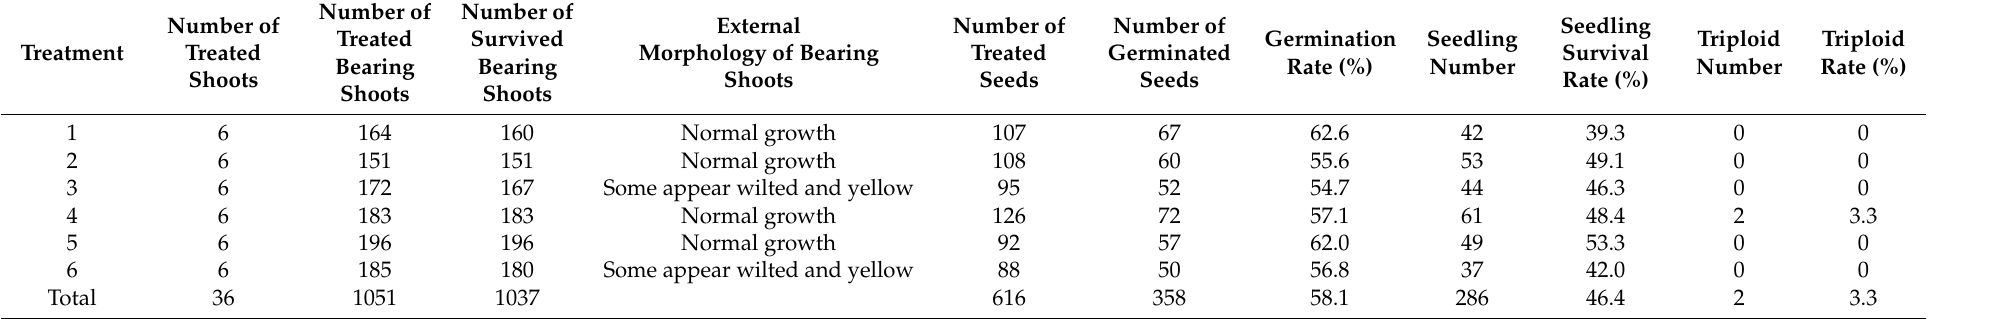
Table 4. The experiment treatment and results of colchicine inducing triploid of ‘Maya’